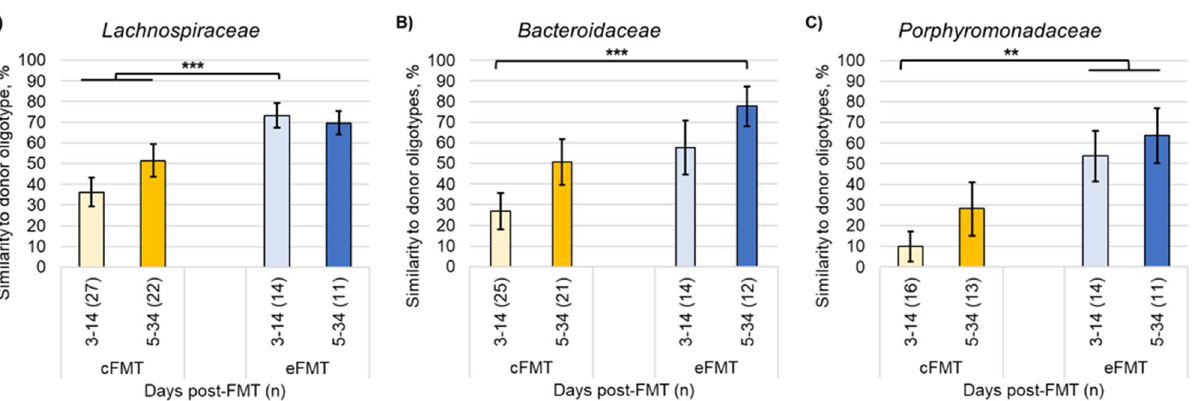
Figure 2. Similarity to donor oligotype profiles. Mean percent similarity to donor oligotype profiles for ( A ) Lachnospiraceae , ( B ) Bacteroidaceae , and ( C ) Porphyromonadaceae , as determined by SourceTracker. Mean was calculated without respect to donor, but only the donor received was used for SourceTracker calculations. Error bars reflect standard error. ** P ≤ 0.01 *** P ≤